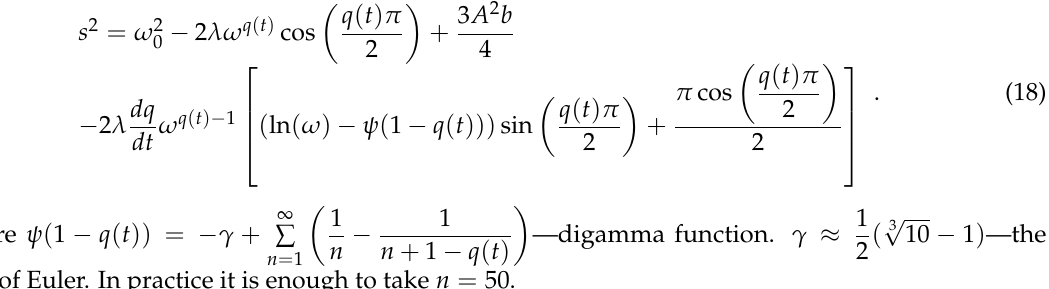
—digamma function. γ ≈